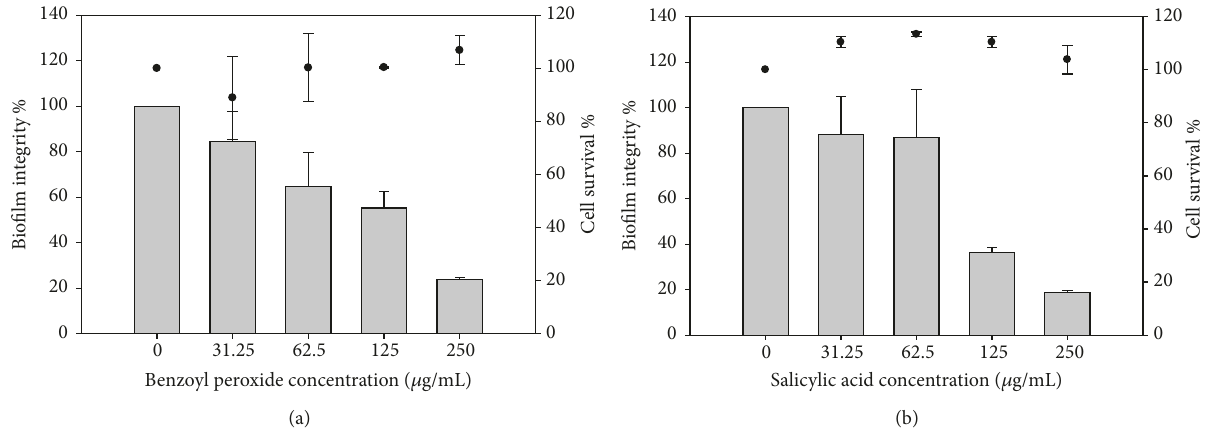
Figure 4: Inhibition of G. vaginalis biofilm by benzoyl peroxide (a) and salicylic acid (b). Biofilm integrity % (gray colour); cell survival % ( e